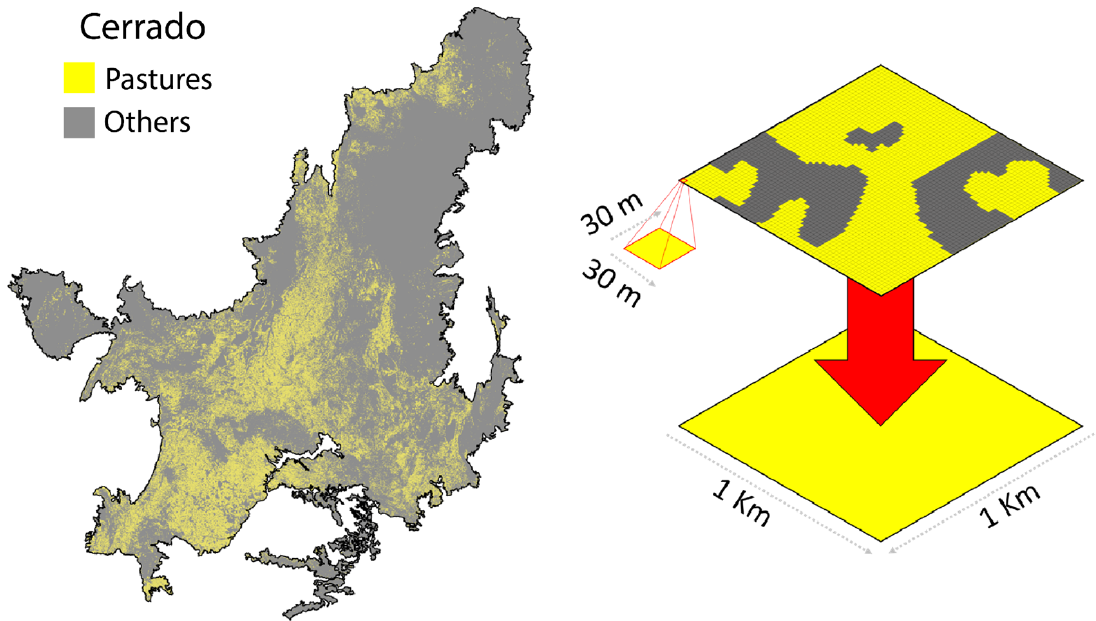
Figure 2. Pasture areas in the Cerrado biome resampled at spatial resolution of 30 m × 30 m to 1 km − 2 were approximately 50.7 Mha in 2017.